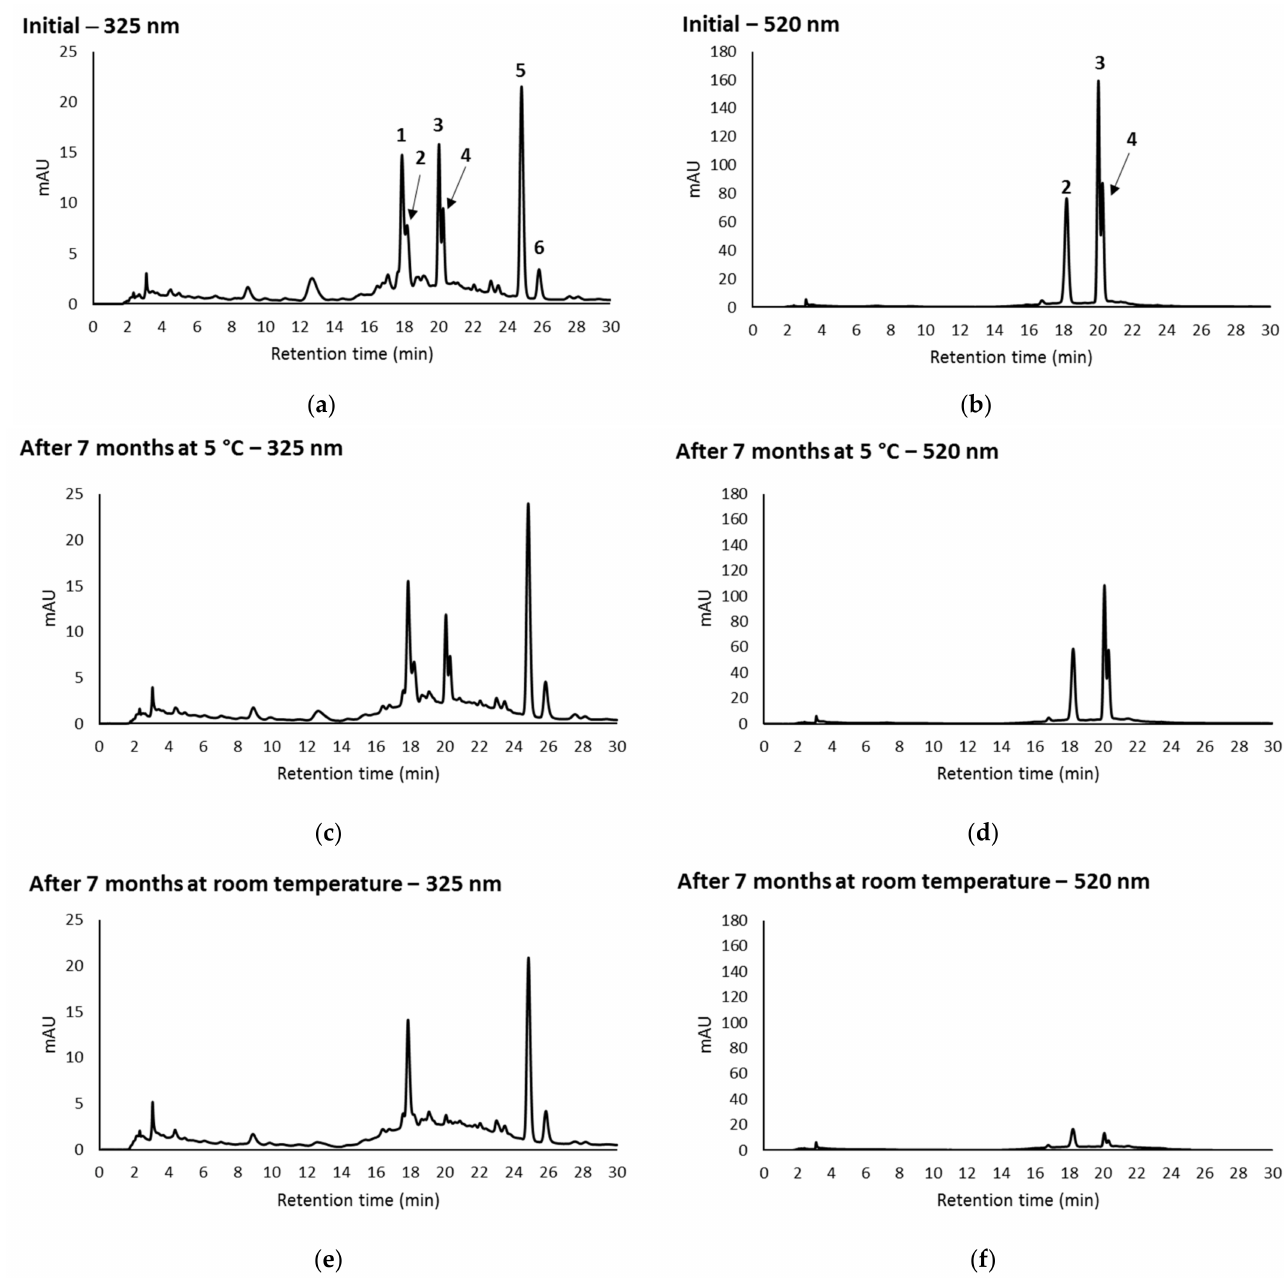
Figure 2. HPLC chromatograms of concentrate I ( a ) before storage with detection at 325 nm, ( b ) before storage with detection at 520 nm, ( c ) after 7 months of storage at 5 ◦ C with detection at 325 nm, ( d ) after 7 months of storage at 5 ◦ C with detection at 520 nm, ( e ) after 7 months of storage at room temperature with detection at 325 nm, and ( f ) after 7 months of storage at room temperature with detection at 520 nm. ( 1 ) Chlorogenic acid, ( 2 ) cyanidin-3- O -sambubioside- 5- O -glucoside + cyanidin-3,5- O -diglucoside, ( 3 ) cyanidin-3- O -sambubioside, ( 4 ) cyanidin-3- O -glucoside, ( 5 ) rutin, and ( 6 ) quercetin-3- O